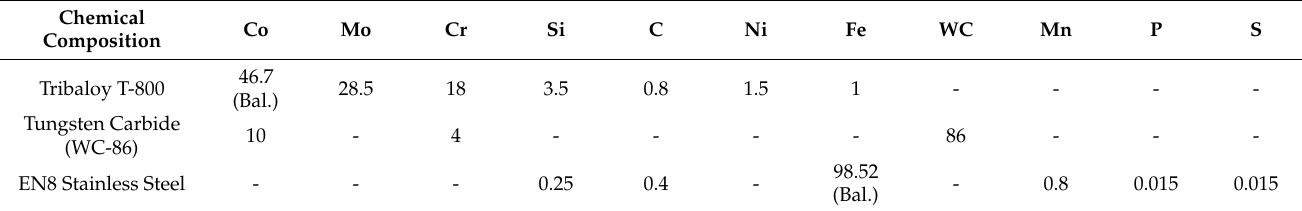
Table 1. Chemical composition of tungsten carbide WC-86 and Tribaloy